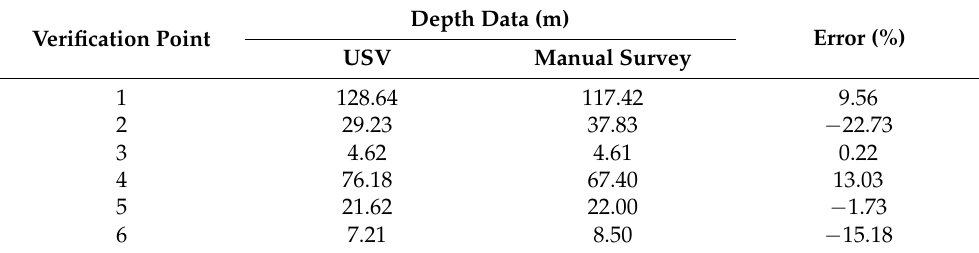
Table 4. Depth data at validation points .